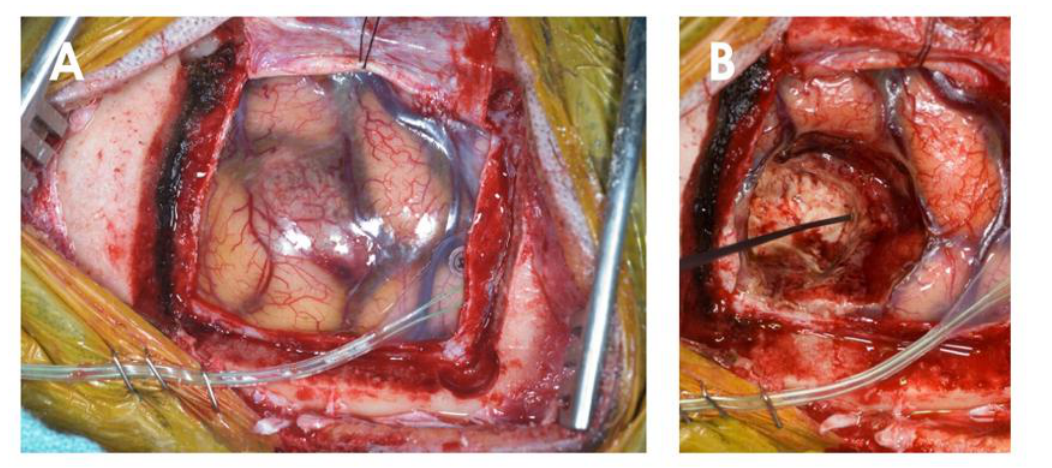
Figure 2. Intraoperative photographs showing the application of electrophysiological recording to ensure removal of the left frontal tumor as demonstrated in Figure 1 without injuring the adjacent motor tract. (A) A paramedian craniotomy was created over the left premotor region. A dural leaf was reflected medially exposing the tumor and the adjacent cortical gyri. Cortical mapping was performed with somatosensory evoked potential recording from a multielectrode array placed posteriorly across the central sulcus. A characteristic phase reversal can differentiate signals originating from the primary motor cortex from those from the primary sensory cortex. (B) A fine tipped stimulating electrode was applied to stimulate the tumor cavity to ascertain the location of the descending motor